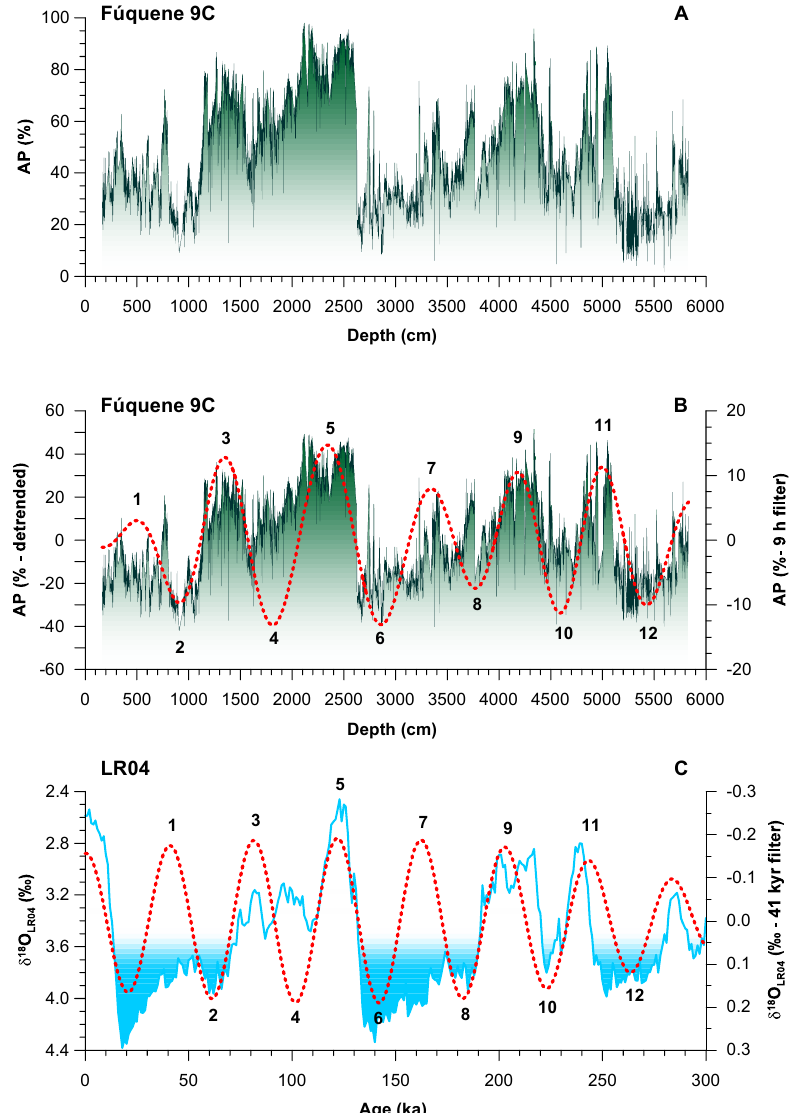
Fig. 4. The AP% data series of core Fq-9C plotted on a depth scale. (A) Raw data. (B) Detrended and interpolated depth series overlain by a Gaussian filter centered at 0.0011 ± 0.0004 (i.e., ∼ 9m component). (C) The LR04 benthic oxygen isotope stack overlain by Gaussian filter centered at 0.0245 ± 0.002 (i.e., 41kyr component). Numbers at each site of the filtered records in B and C indicate the age control points (see also Table 1) between the AP% depth series of core Fq-9C and that of the LR04 stacked record (see text for explanations and